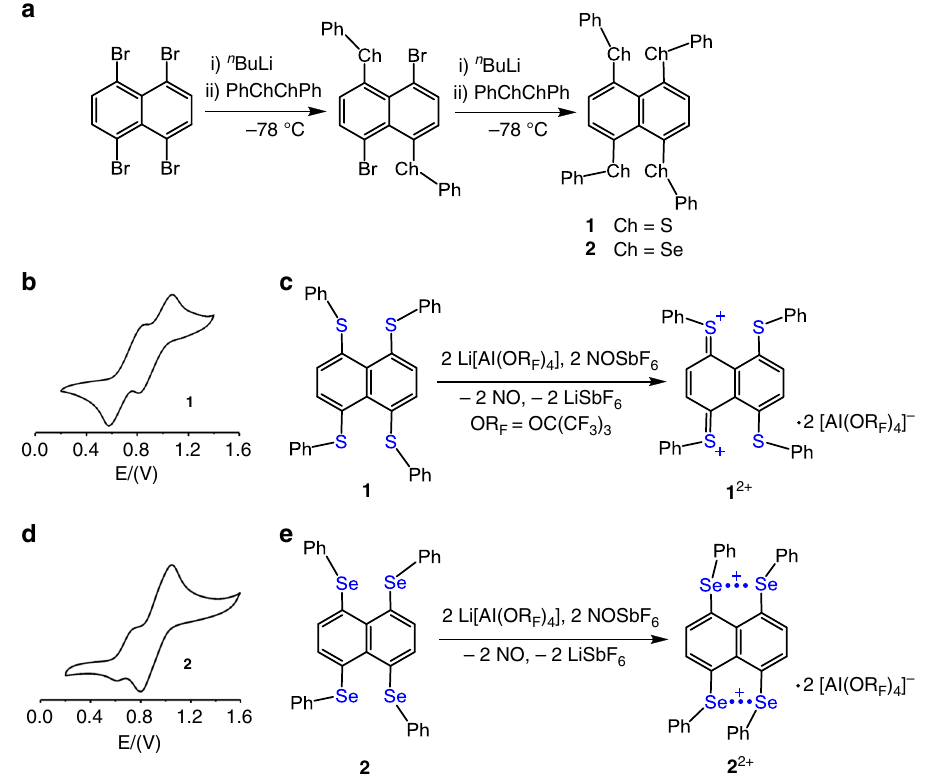
Fig. 2 Preparation, cyclic voltammograms, and two-electron oxidation of tetrachalcogenides 1 and 2. a Preperation of compounds 1 and 2 . b The cyclic voltammetry of 1 . c Two-electron oxidation of 1 . d The cyclic voltammetry of 2 . e Two-electron oxidation of 2